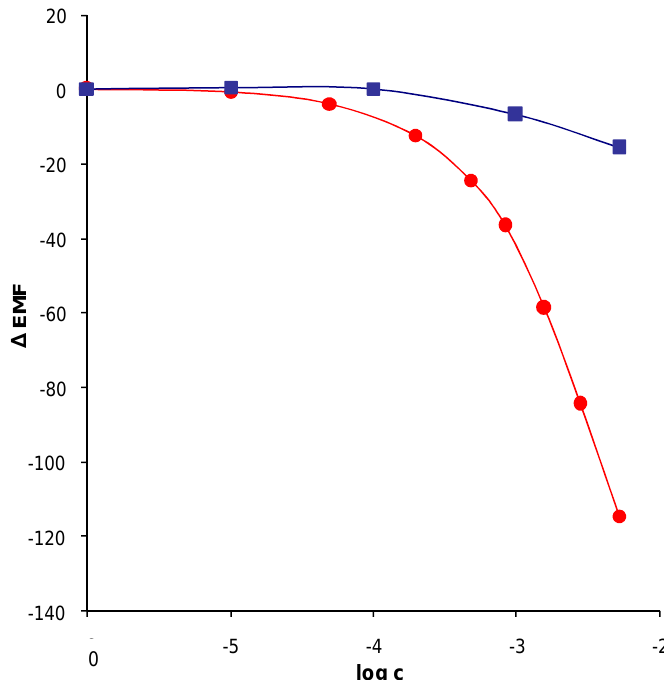
Figure 3 . Potential changes vs. concentration curves obtained for ISEs doped with ligand ( ■ ) and ligand + 50% TDDMACl ( ● ). Measurements were taken in 1.0 x 10 -2 M NaHSO pH 3.0 (n = 4; 0,31 < 4 SD <